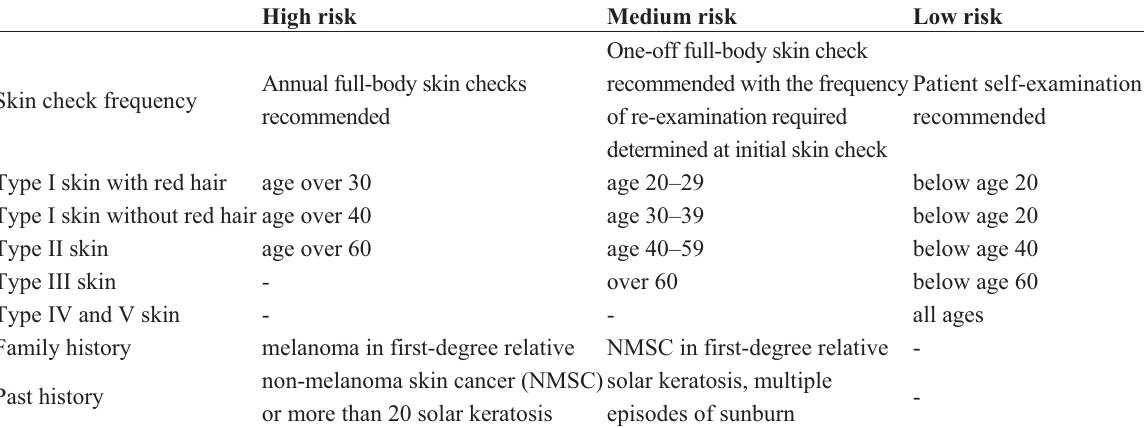
Table 3. Assessment of skin cancer risk. At-risk patients are stratified by skin type, age and family history. A patient’s current risk level is determined by having at least one of the risk factors listed in the high, medium or low risk columns. For example, a patient may be considered high risk if they have a positive family history or if they have Type I skin and are over the age of 30. Risk levels can change with age and on detection of a melanoma or non-melanoma skin cancer and surveillance frequency should be adjusted accordingly. High risk Medium risk Low